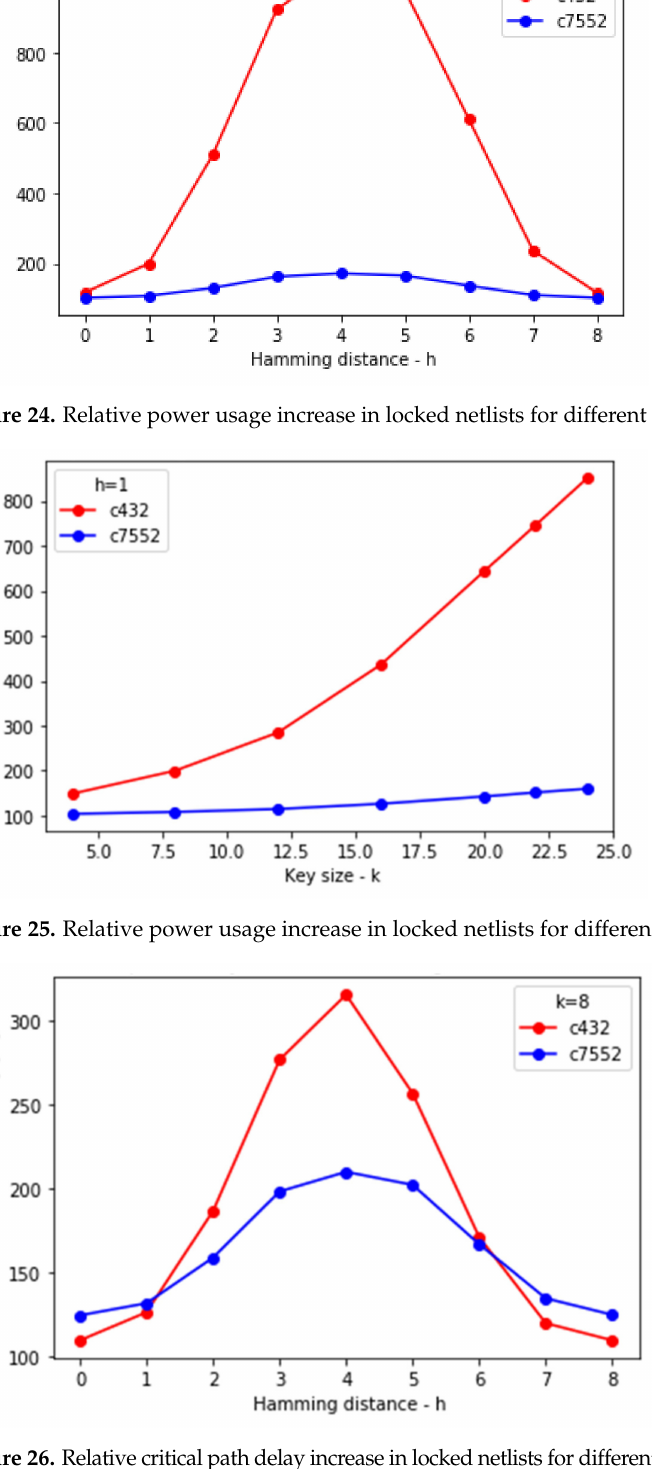
Figure 26. Relative critical path delay increase in locked netlists for different values of Hamming distance. (1) Area: The main factor that causes area overhead was the addition of new gates in the functionality strip and Restore functions. The number of added gates is proportional to (cid:18)